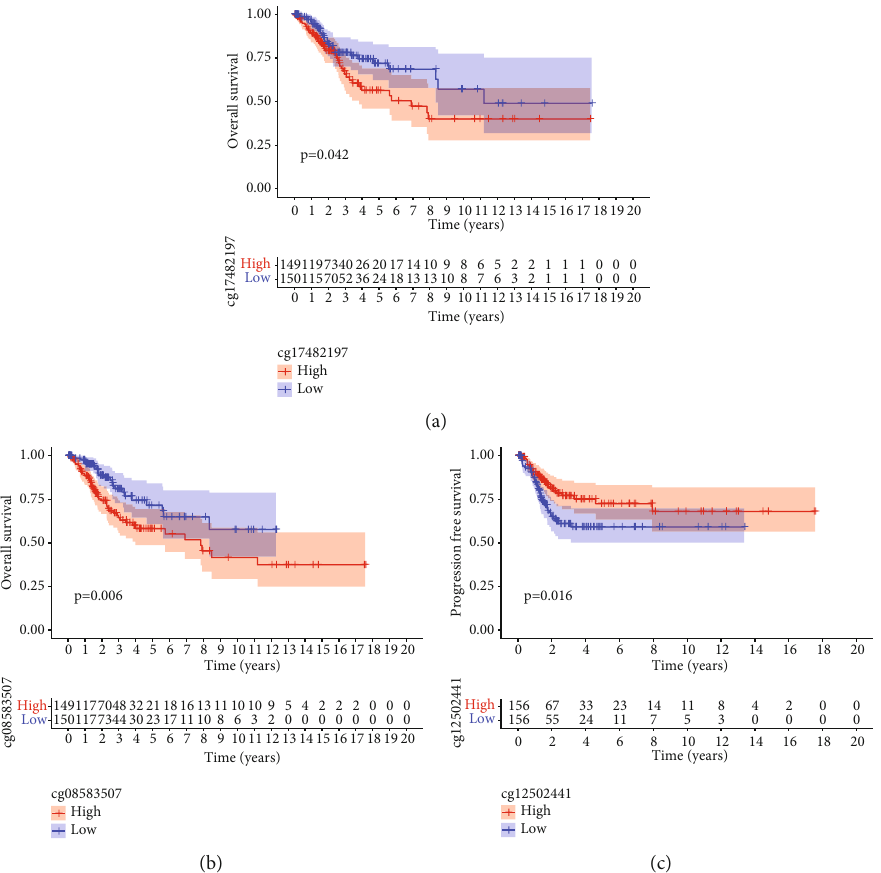
Figure 4: Survival analysis of PMEPA1 CpG site methylation in CC. (a, b) High levels ofcg17482197 and cg08583507 showed a poor prognosis. (c) Low levels of cg12502441 showed a poor prognosis in CC